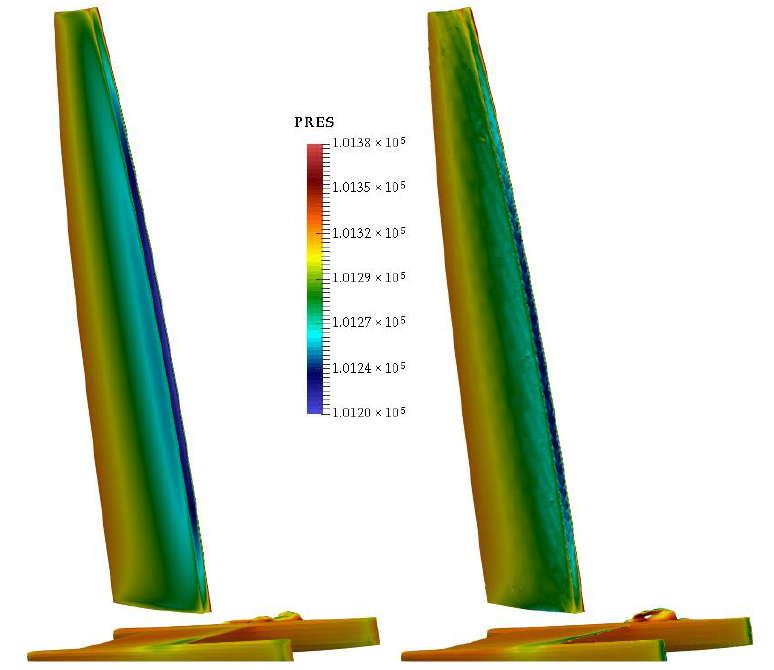
Figure 28. Comparison of pressure distribution obtained with the two solvers.